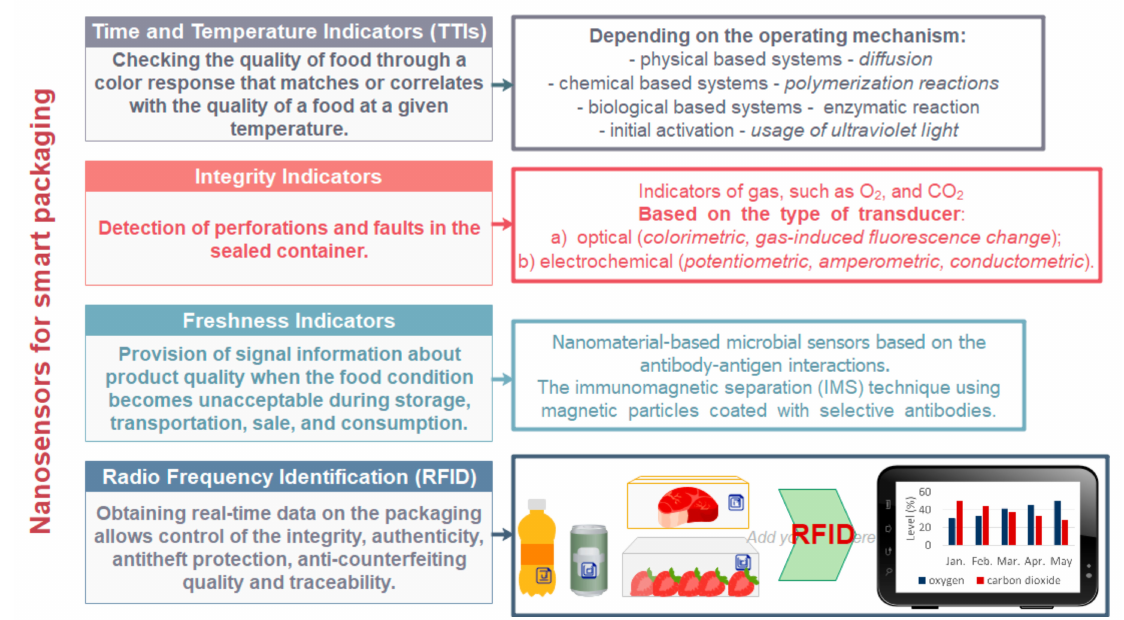
Figure 7. Nanosensors used in smart packaging for food applications [111,112].